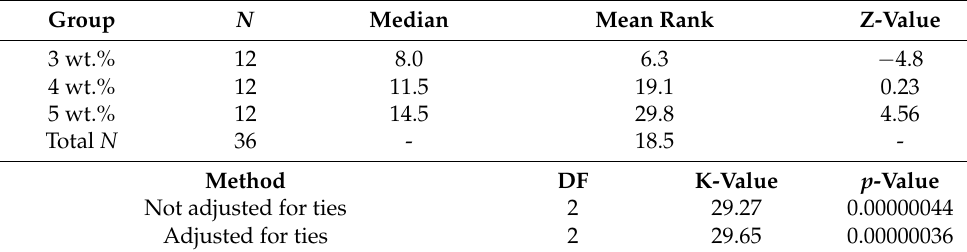
Figure 6. Temperature monitoring over 15 min in mixing processes assisted with and without a reverse bain-marie; the manufacturer’s recommended temperature is <20 ◦ C. Table 3. Independent samples Kruskal–Wallis test summary.